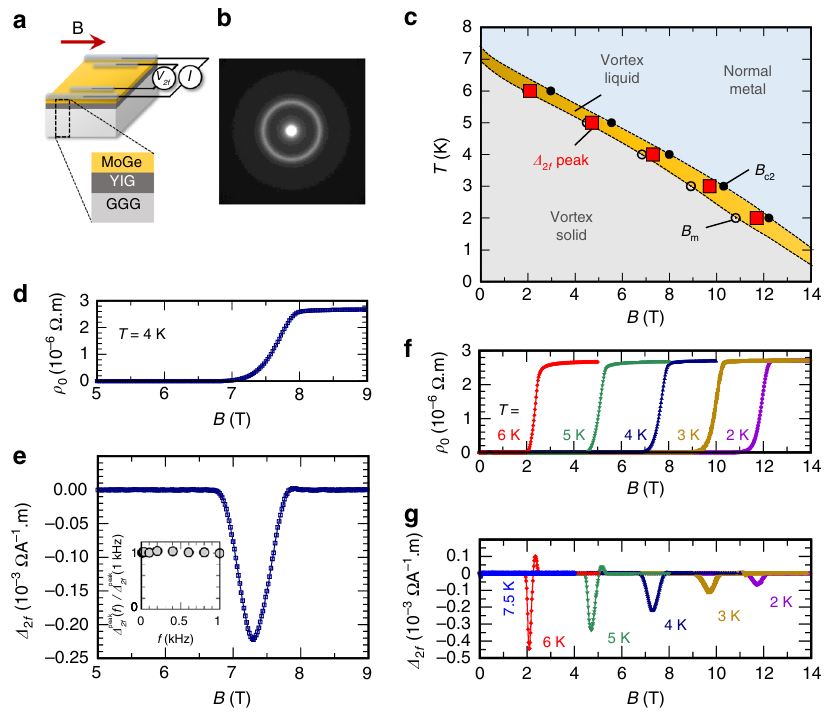
Fig. 2 Observation of nonreciprocal transport in MoGe|YIG. a A schematic illustration of the sample structure and measurement setup. The MoGe| Y 3 Fe 5 O 12 (YIG) sample on a Gd 3 Ga 5 O 12 (GGG) substrate is placed in a magnetic fi eld almost parallel to the sample surface. An a.c. input current I with a frequency f is applied to the sample, and V 2 f , the a.c. voltage signal with frequency 2 f , is measured. b Electron diffraction pattern from the MoGe layer. c The B – T phase diagram of the MoGe and appearance of non-zero nonreciprocal resistivity denoted as Δ 2 f ≠ 0 peak. The vortex-solid melting fi eld B m and the upper critical fi eld B c2 were determined by the conditions ρ ( B m ) = 10 − 3 ρ N and ρ ( B c2 ) = 0.95 ρ N , respectively, where ρ N is the resistivity in the normal state. Dotted lines are guides for eyes. d Magnetic fi eld dependence of resistivity ρ 0 at T = 4 K. e Magnetic fi eld dependence of nonreciprocal resistivity coef fi cient Δ 2 f ( I 0 = 40 μ A, f = 13.7 Hz). Inset: Frequency dependence of the peak value of Δ 2 f divided by the peak value at f = 1 kHz, Δ peak